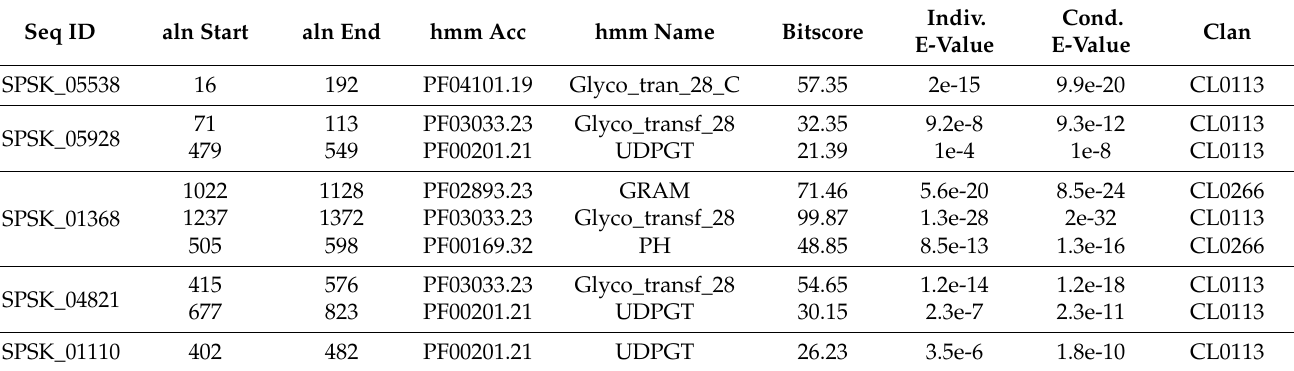
Table 2. Domains detected for the putative rhamnosyltransferases identified on the Sporothrix schenckii